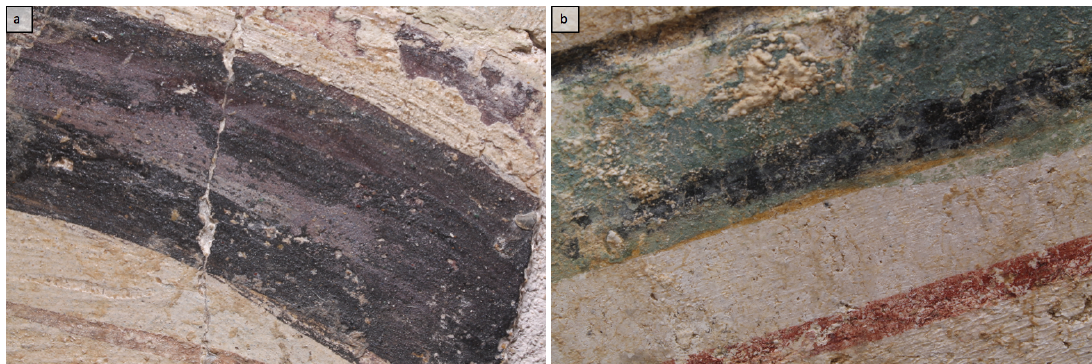
Figure 19. ( a ) Details of a figurative painting from the House of Aion: tunic shading is achieved using layers of purple and black to produce optical effects of light and dark purple hues (E5); ( b ) From Tomb 3882, a black pigment was used for outlining geometric bands